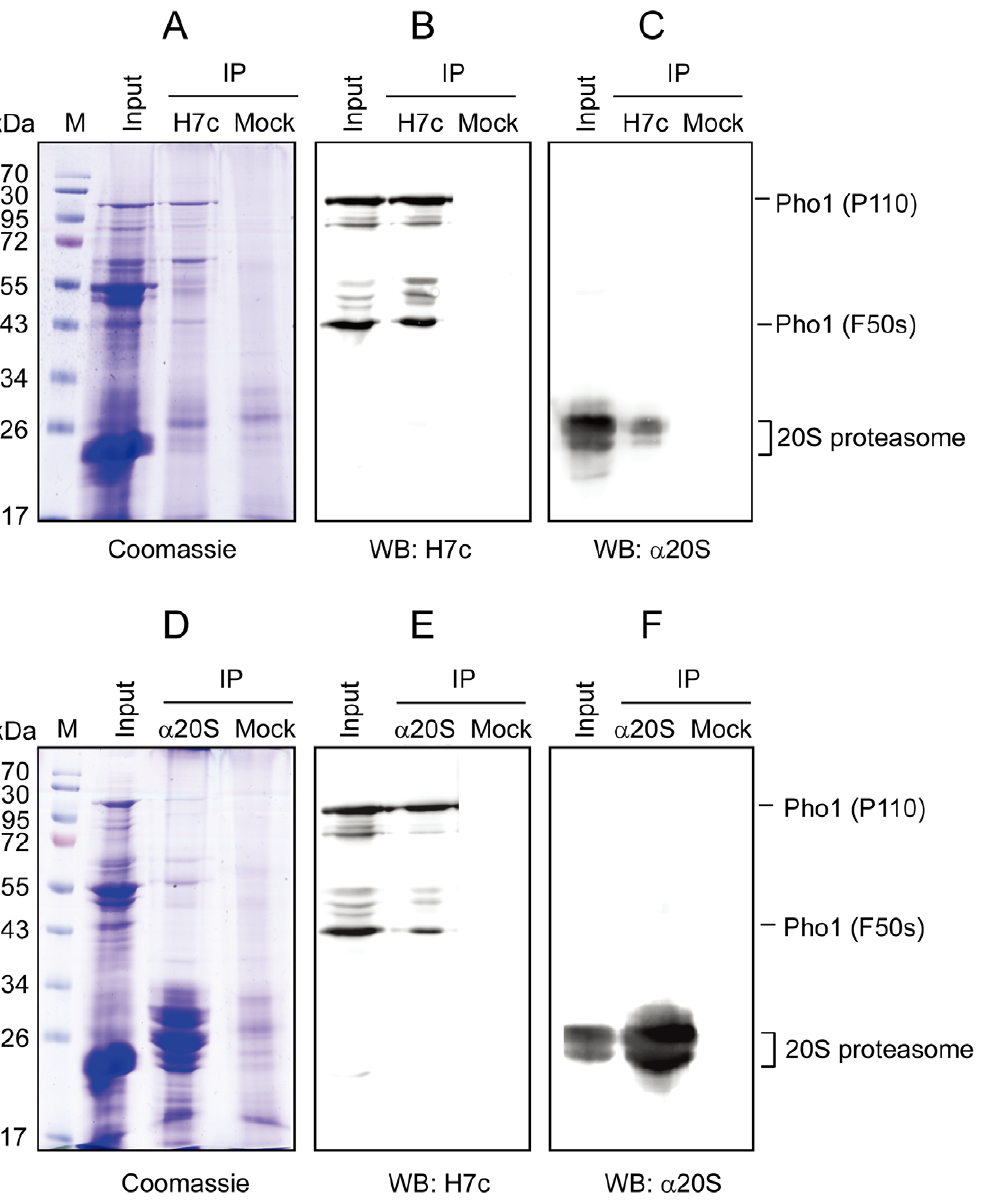
Figure 3. The 20S proteasome was co-immunoprecipitated by Pho1 specific monoclonal antibody H7c from whole cell extracts of sweet potato roots. Pho1 specific monoclonal antibody H7c-crosslinked Protein A Sepharose CL-4B beads were used to pull down Pho1 from the whole cell extracts in order to study the interaction between Pho1 and the 20S proteasome. After the immunoprecipitation procedures, beads were incubated with SDS-PAGE sample buffer at 100 u C for 10 min and separated by 12.5% SDS-PAGE. The gels were either stained with Coomassie ( A ) or transferred to PVDF membranes for staining with H7c ( B ) and anti-20S proteasome ( C ) primary antibodies. One tenth of the input crude extracts (10 m g) was applied on the gel for comparison (Input). The control experiment was performed by replacing H7c with unrelated monoclonal antibody (Mock). Alternatively, anti-20S proteasome antibody-crosslinked Protein A Sepharose CL-4B beads were also used to pull down 20S proteasomes from whole cell extracts. After the immunoprecipitation procedures, the gels were either stained with Coomassie ( D ) or transferred to PVDF membranes for staining with H7c ( E ) and anti-20S proteasome ( F ) primary antibodies. M, prestained SDS-PAGE molecular weight standards. doi:10.1371/journal.pone.0035336.g003 (Fig. 5A, + MG132, Activity staining, WB: H7c, WB: a L78). Furthermore, the intact Pho1 remained clearly detectable even after 6–12 h of heat treatment by pretreating sweet potato roots with MG132 (Fig. 5A, + MG132, WB: H7c, WB: a L78), while they were largely degraded or not found in the control experiments (Fig. 5A, Control, WB: H7c, WB: a L78), indicating that the proteasome is involved in Pho1 degradation under heat treatment at 45 u C. The data of the densitometry measurement of the intact